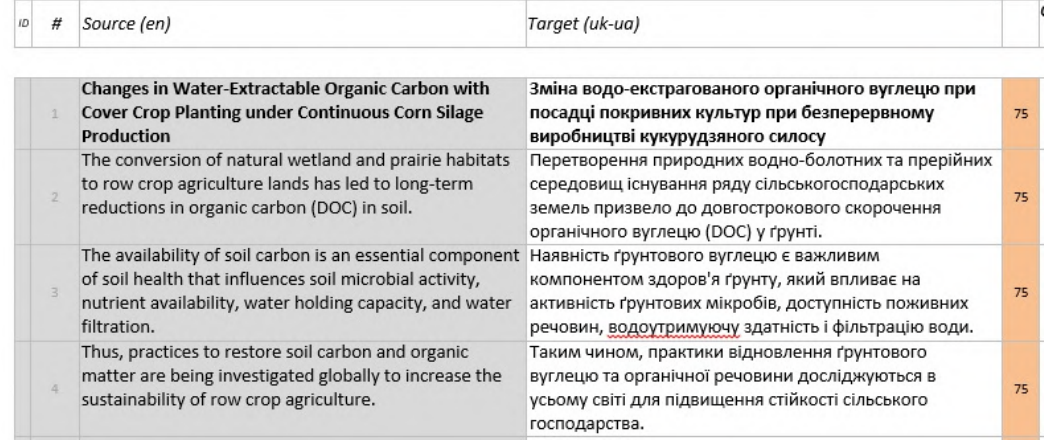
Figure 8: Checking the correctness of the translation by comparing segments of the source and target